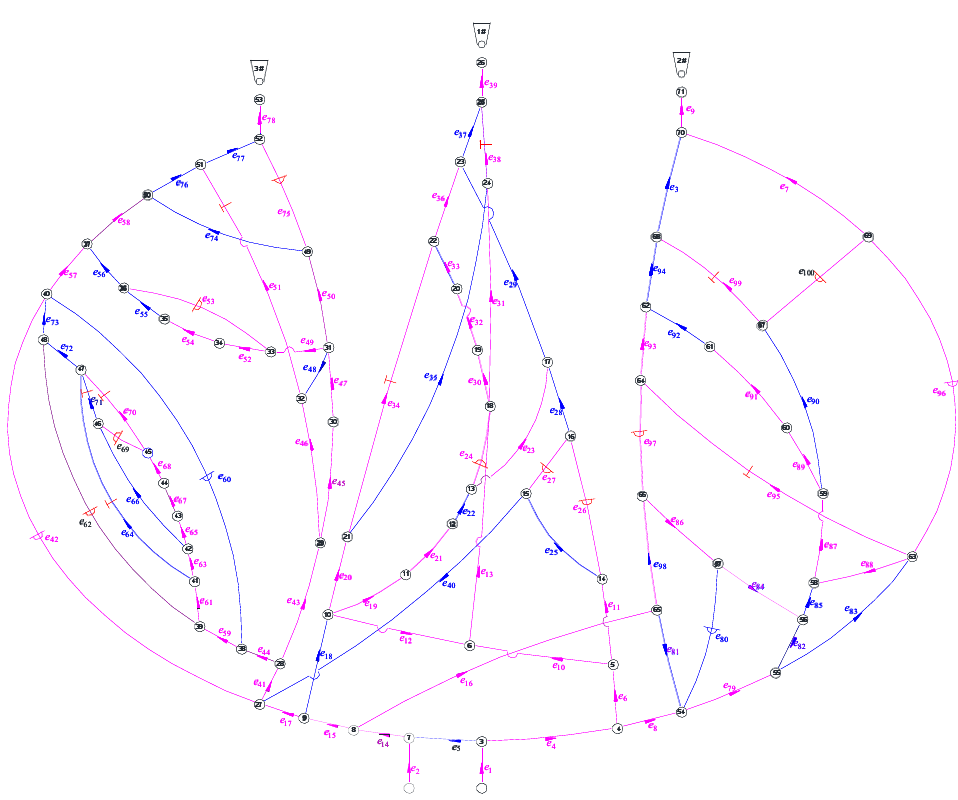
Figure 7. A coal mine ventilation system used by Jinmei Co., Ltd. (Red indicates the position of air doors or wind windows, and black arrows indicate the exhaust air flow. Green is the incoming air flow as well as the fresh air flow. Each number indicates the junction number and tunnel number).